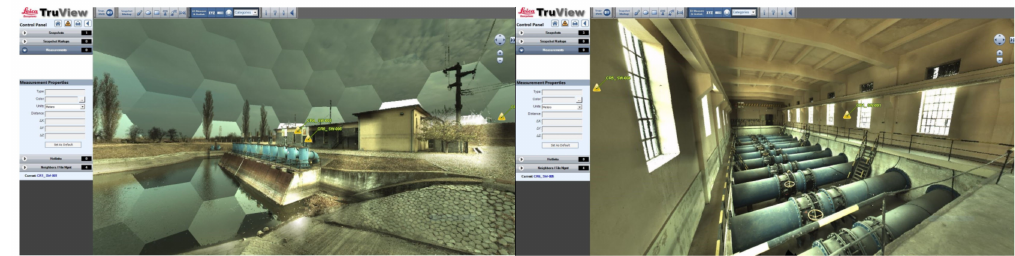
Figure 23. TruView link for the Lock from S â nmartinu Maghiar.